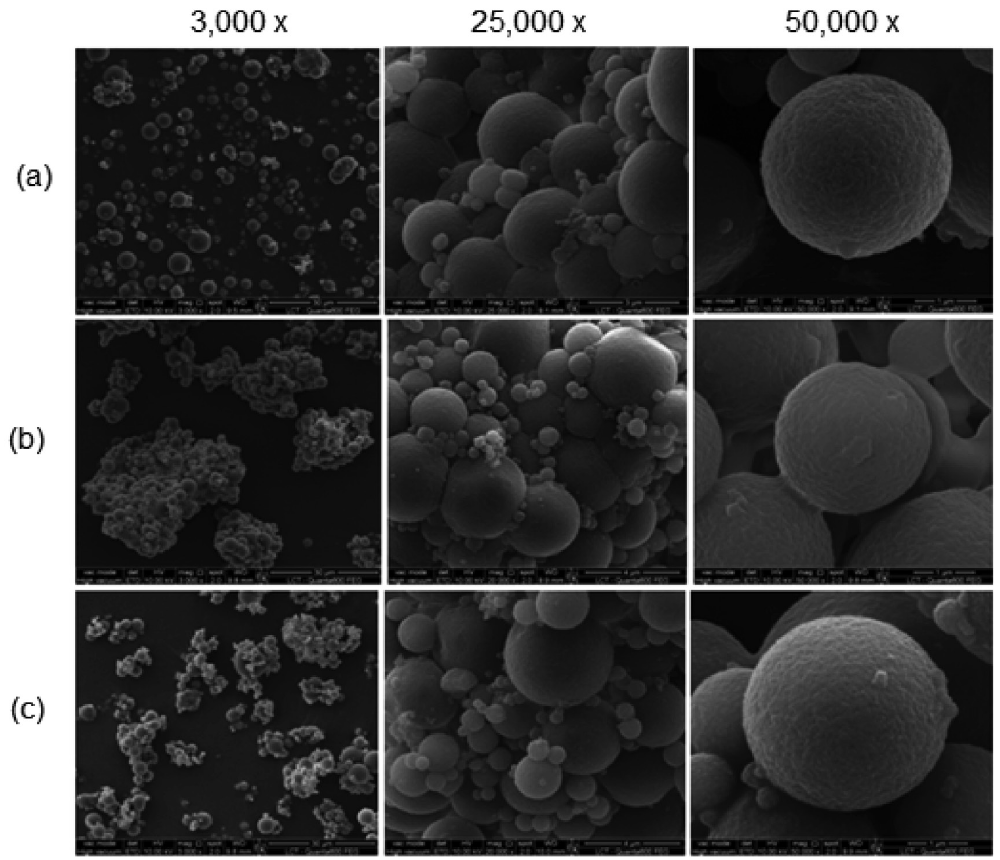
FIGURE 2 - SEM photomicrographs of M0 (a), MG (b) and MR (c) at a magnification of 3,000x, 25,000x and